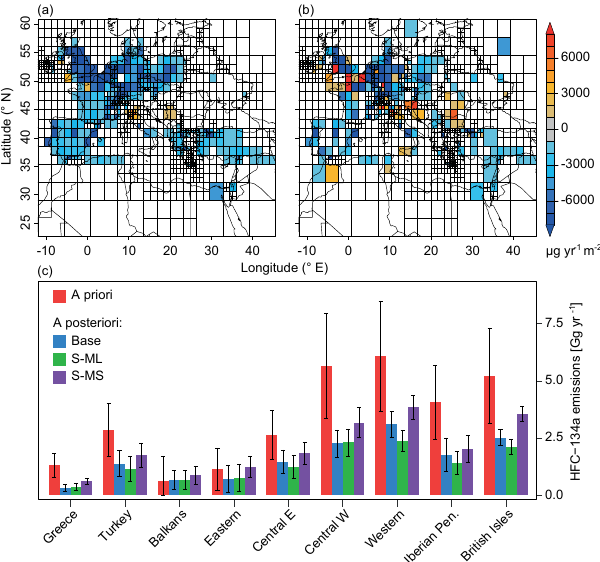
Figure 6. Difference of the a posteriori and a priori emissions for (a) the S-ML and (b) the S-MS inversions of HFC-134a. (c) Re- gional emission estimates: a priori emissions (red) and a posteri- ori emissions (BASE is blue, S-ML is green, S-MS is purple). The uncertainties given are 2 standard deviations of the analytic uncer- tainty assigned to the a priori emissions and derived by the inversion as a posteriori